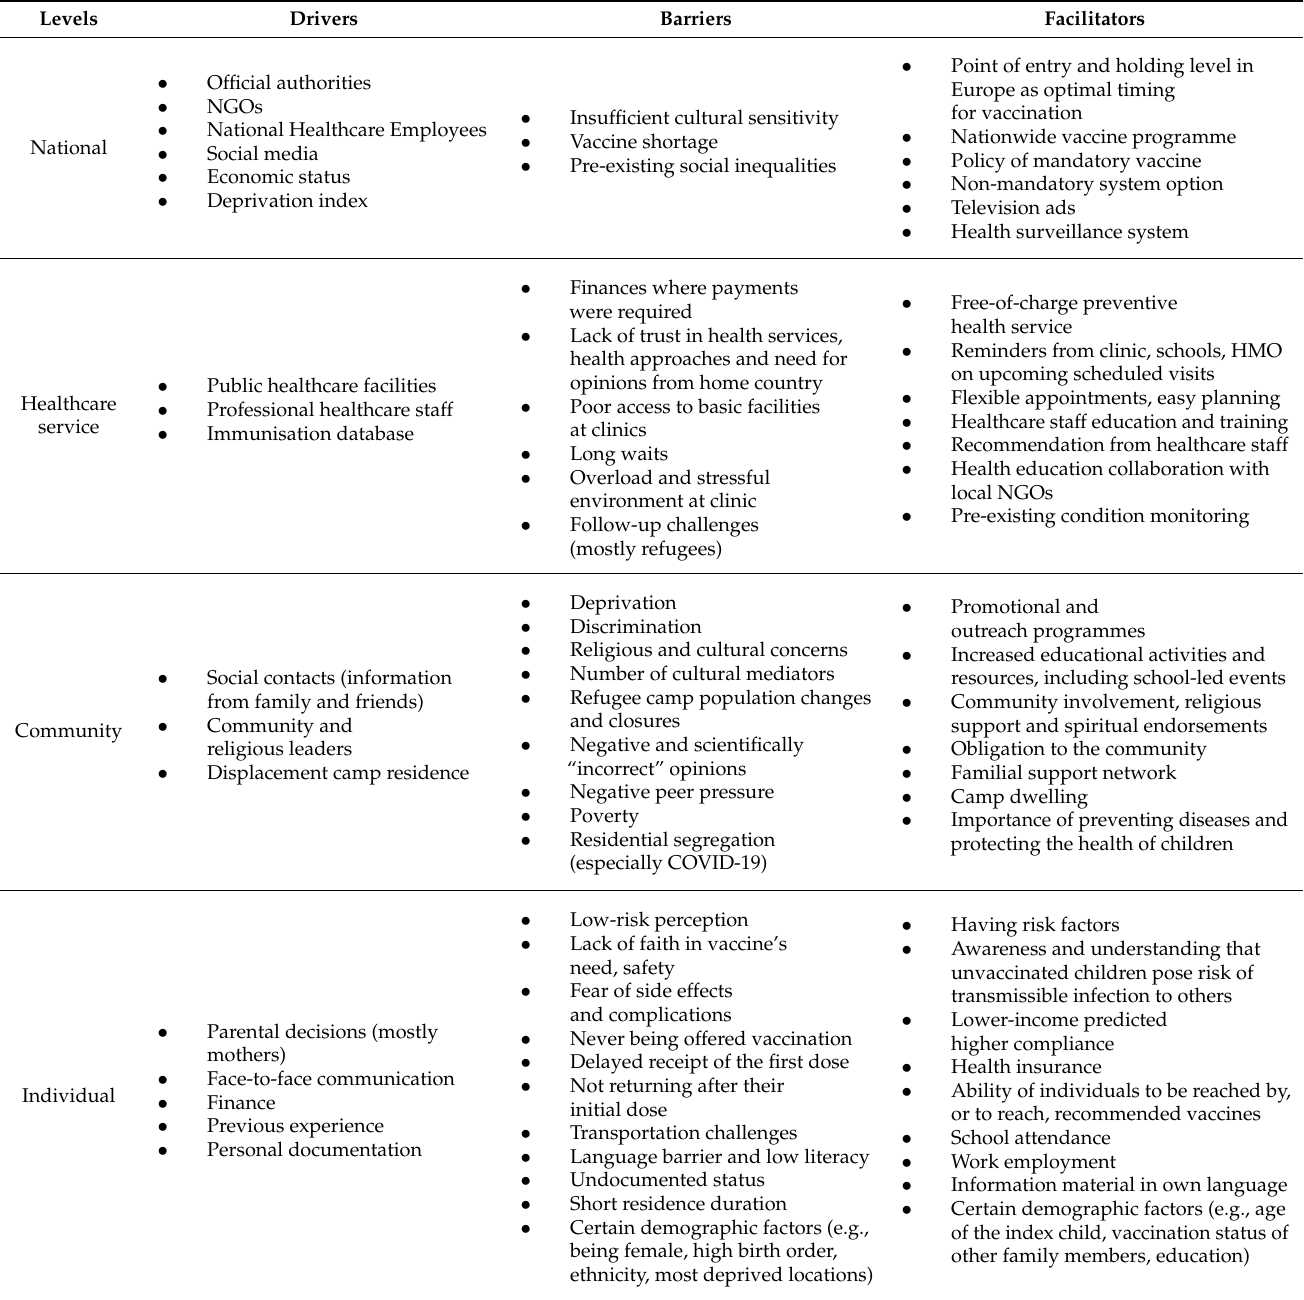
Table 2. Summary of identified drivers, barriers and facilitators of